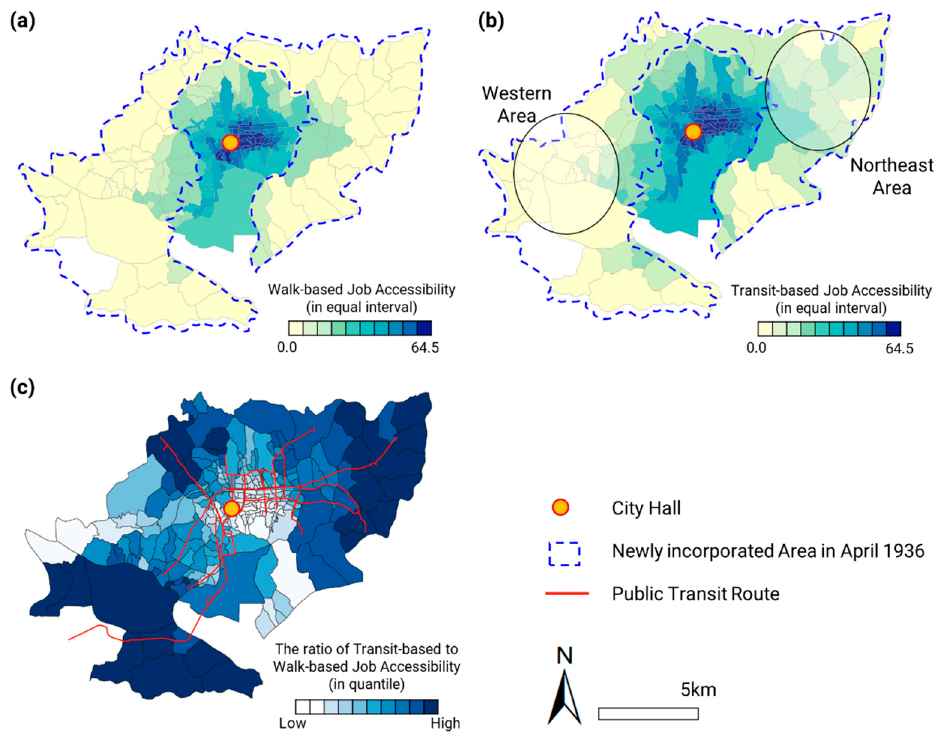
Figure 5. ( a ) Walk‑based job accessibility, ( b ) transit‑based job accessibility, and ( c ) the ratio of transit‑based to walk‑based job accessibility at the neighborhood level of the study area.